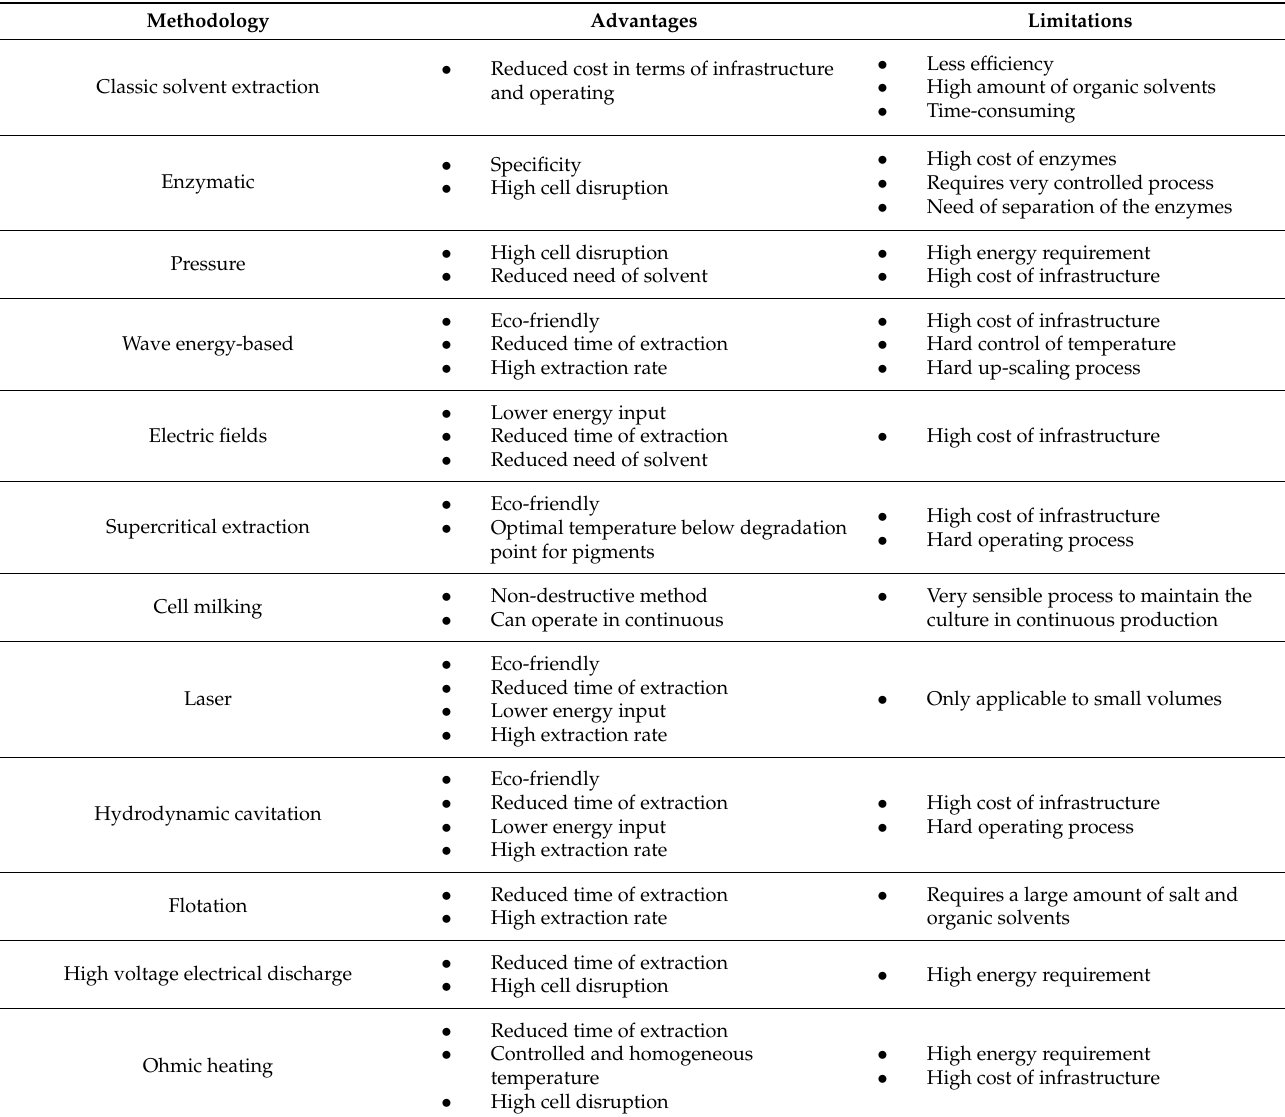
Table 2. Advantages and limitations of the different methods for extraction of pigments in microalgae and cyanobacteria.